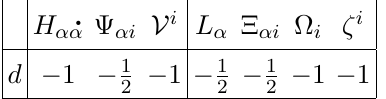
Table 6 . Engineering dimensions. Engineering dimension ( d ) of the graviton, gravitini, and Kaluza- Klein prepotentials and their gauge parameters. Because h G i = 1, we do not assign conformal and U(1) R